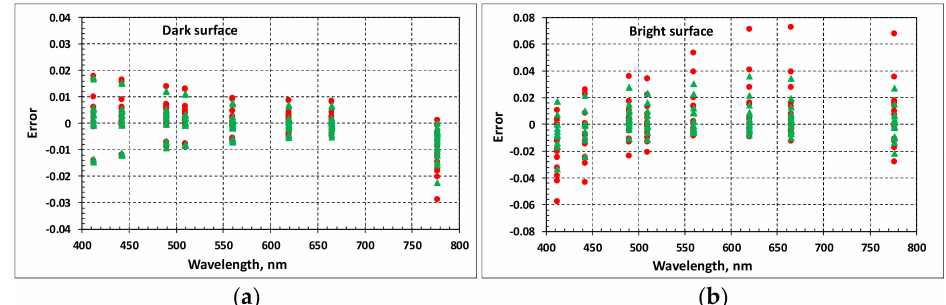
Figure 5. Errors in retrieving surface spectral reflectance in the MS channels for dark surfaces ( a ) and bright surfaces ( b ) at solar zenith angles 60 ◦ (red circles) and 20 ◦ (green triangles).